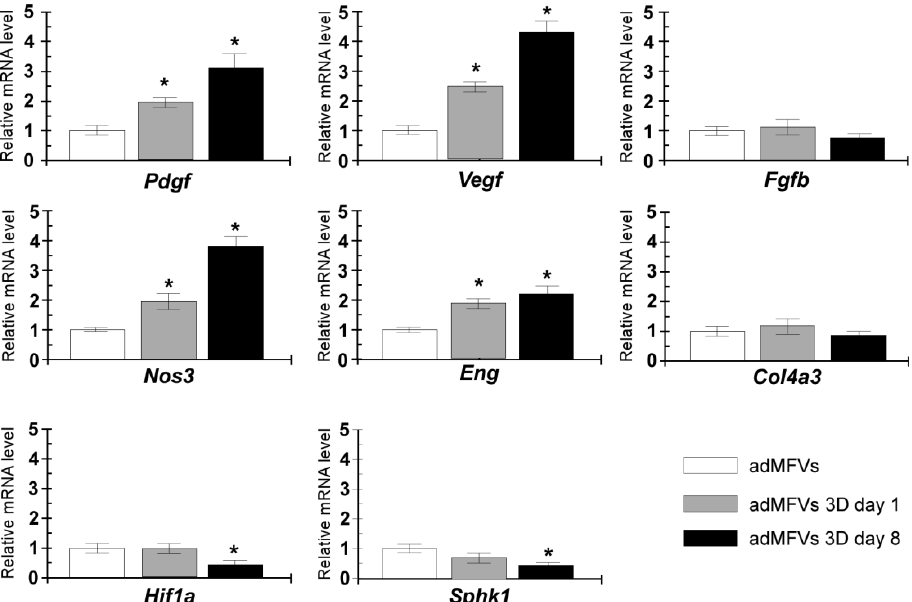
Figure 6. Gene expression analyses of Col4a3 , Nos3 , Pdgf , Fgfb , Vegf , Sphk1 , Hif1a , and Eng . The RT-qPCR assays were performed in newly extracted ad-MFVs and sprouting ad-MFVs at day 1 and day 8 in 3D collagen type-I hydrogel. The gene expression levels were analysed using the 2- ΔΔ Ct method using Gapdh as the reference gene. The data represent the mean ± SD of three independent culture experiments. Bars with an asterisk are significantly different at p < 0.05.